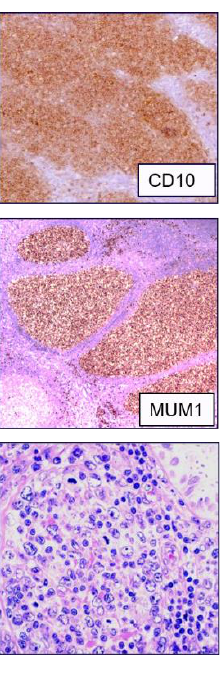
Figure 4. Follicular Lymphomas (FL) in young patients (<30 years) include pediatric type FL, IRF4 large B-cell lymphoma, testicular FL. Modified and adapted from Liu Q et al. [16]